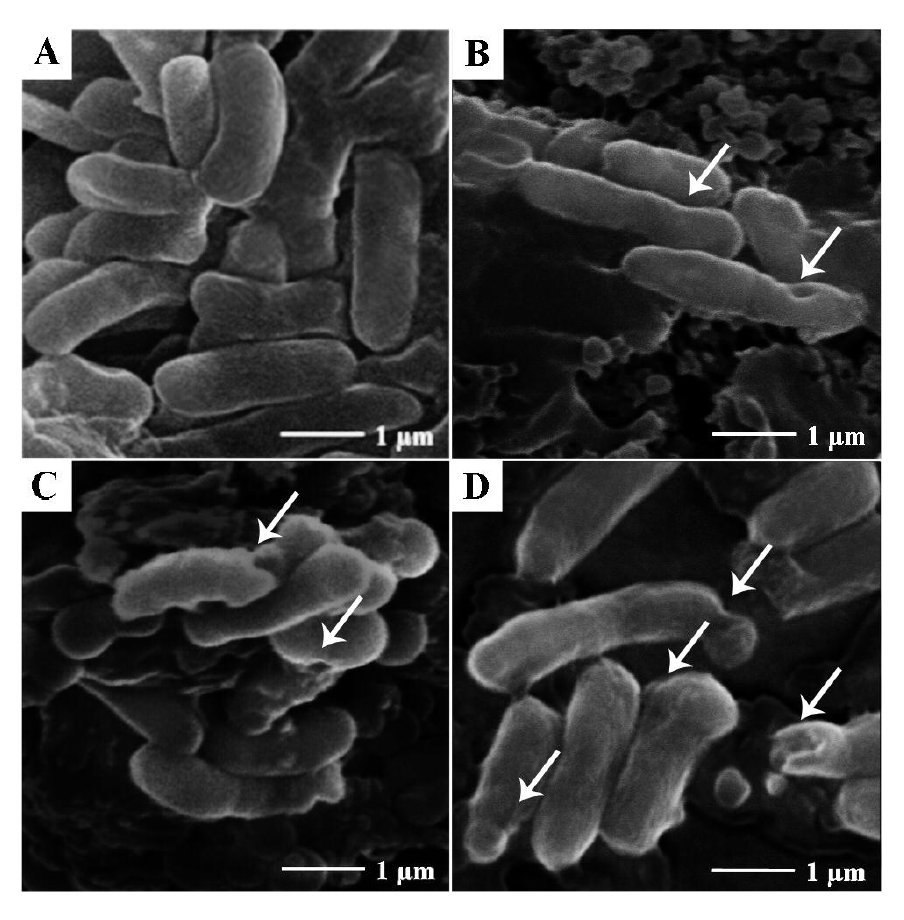
Figure 5. Scanning electron micrograph of K. pneumoniae BAA-1705. ( A ) Non-treated cells, ( B ) cells treated with CBO (0.08%), ( C ) cells treated with meropenem (16 µg/mL), ( D ) cells treated with combination of CBO (0.08%) and meropenem (16 µg/mL).